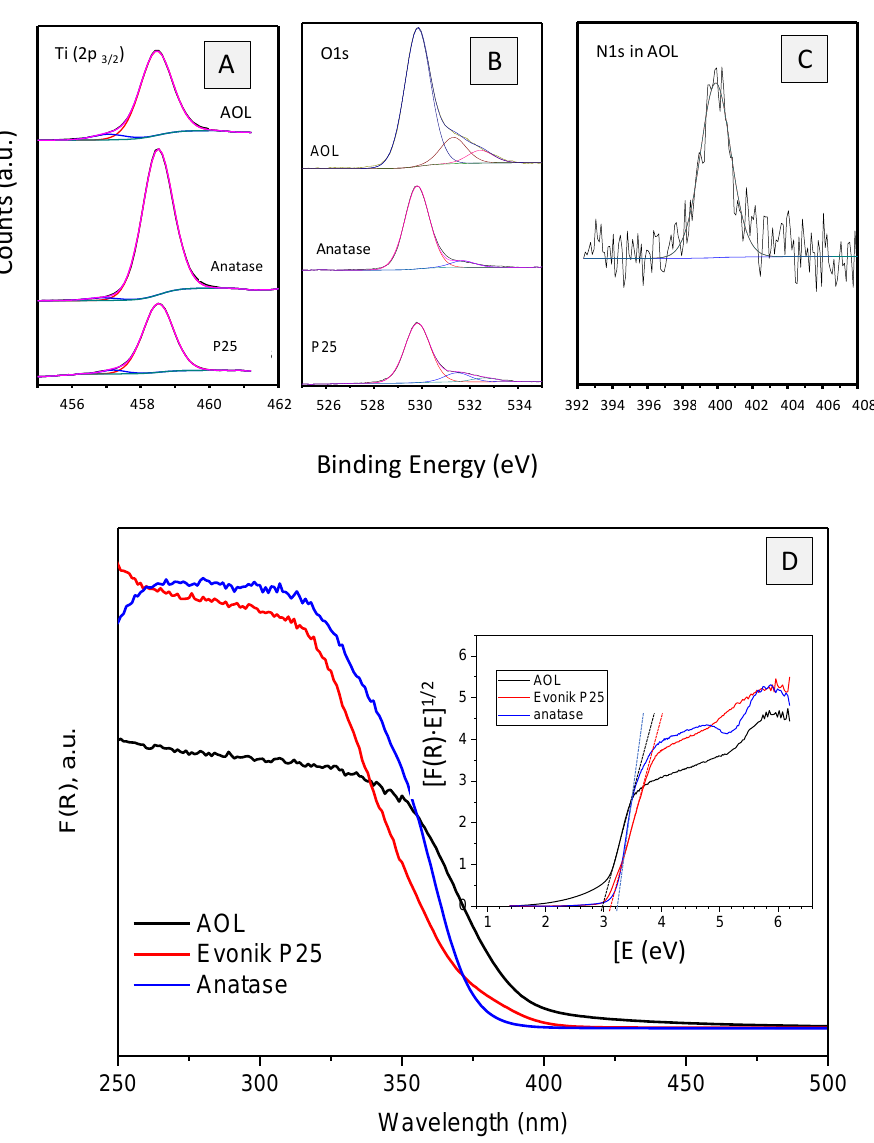
Figure 6. Characterization of AOL. X-ray photoelectron (XPS) profiles of Ti 2p 3 / 2 ( A ), O 1s ( B ) and N 1s ( C ). Titanium and oxygen profiles of anatase and Evonik P25 have also been included for comparison. ( D ) UV-Vis spectra of AOL, anatase and Evonik P25. The inset represents the plot of transformed Kubelka–Munk function vs. the energy of the absorbed light for determination of the band-gap energy.